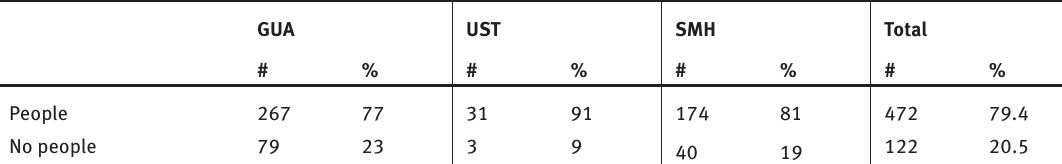
Table 5: Number of images depicting or not depicting people in migratory images